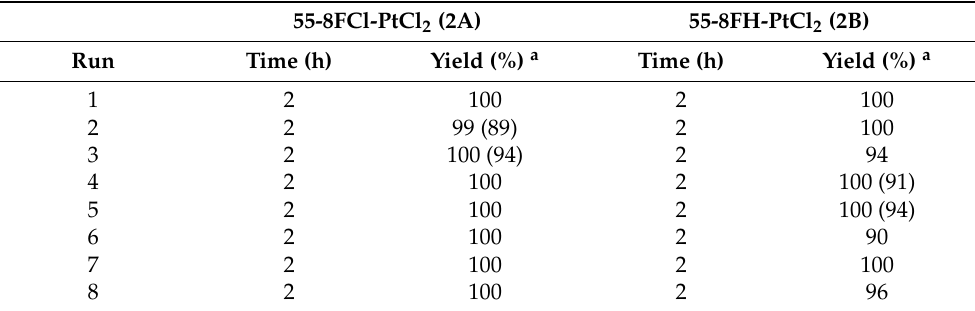
Table 1. Hydrosilylation reactions of 5-decyne ( 4 ) and triethylsilane ( 3 ) in the presence of 2A and 2B catalysts.